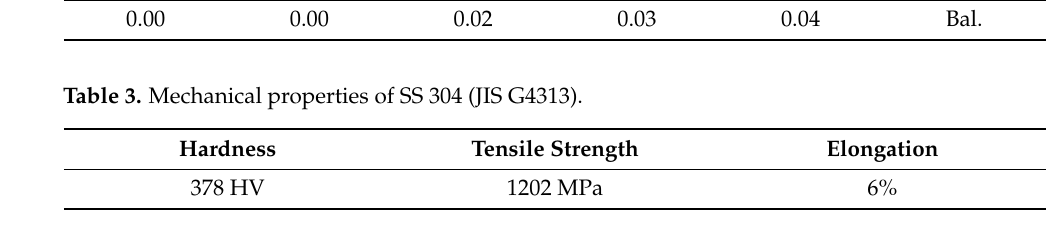
Table 2. Chemical composition of pure titanium in wt.% (JIS H 4600 TR270C). N